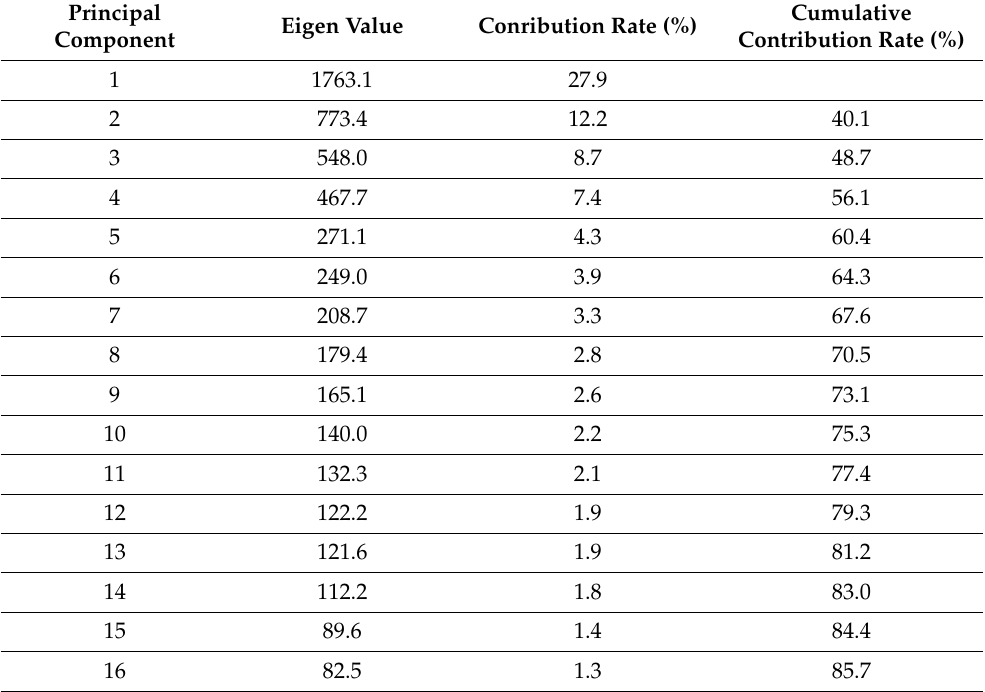
Table 3. Principal component in total mandible.